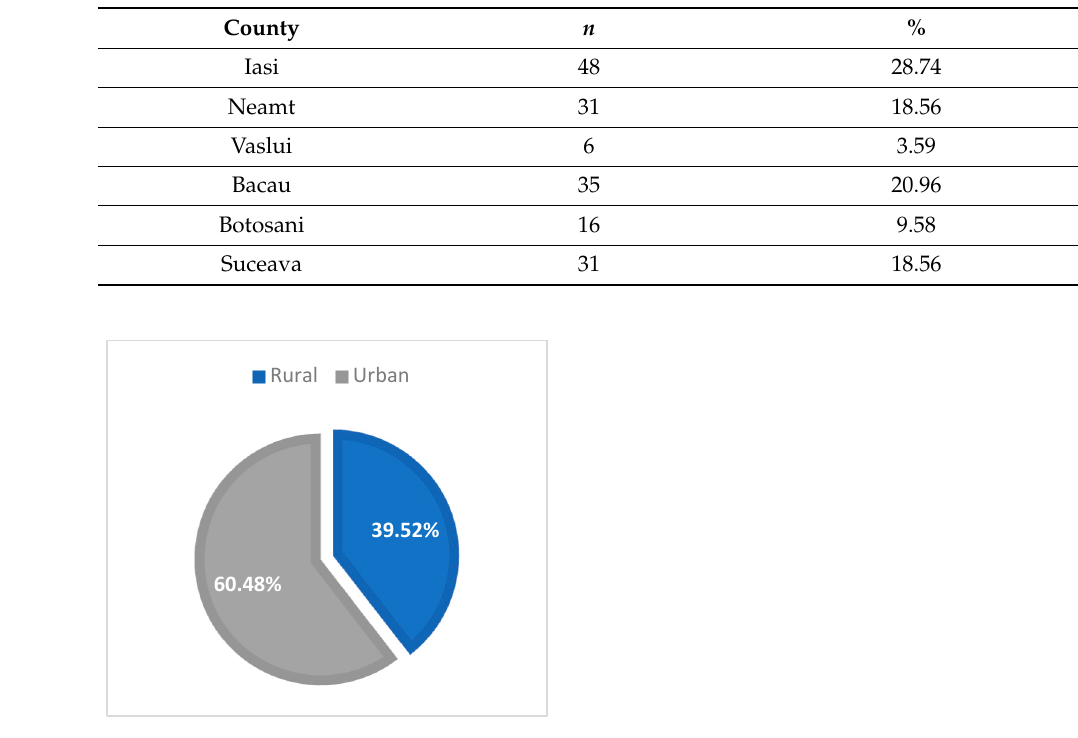
Figure 2. New HIV/AIDS cases, distribution by area.